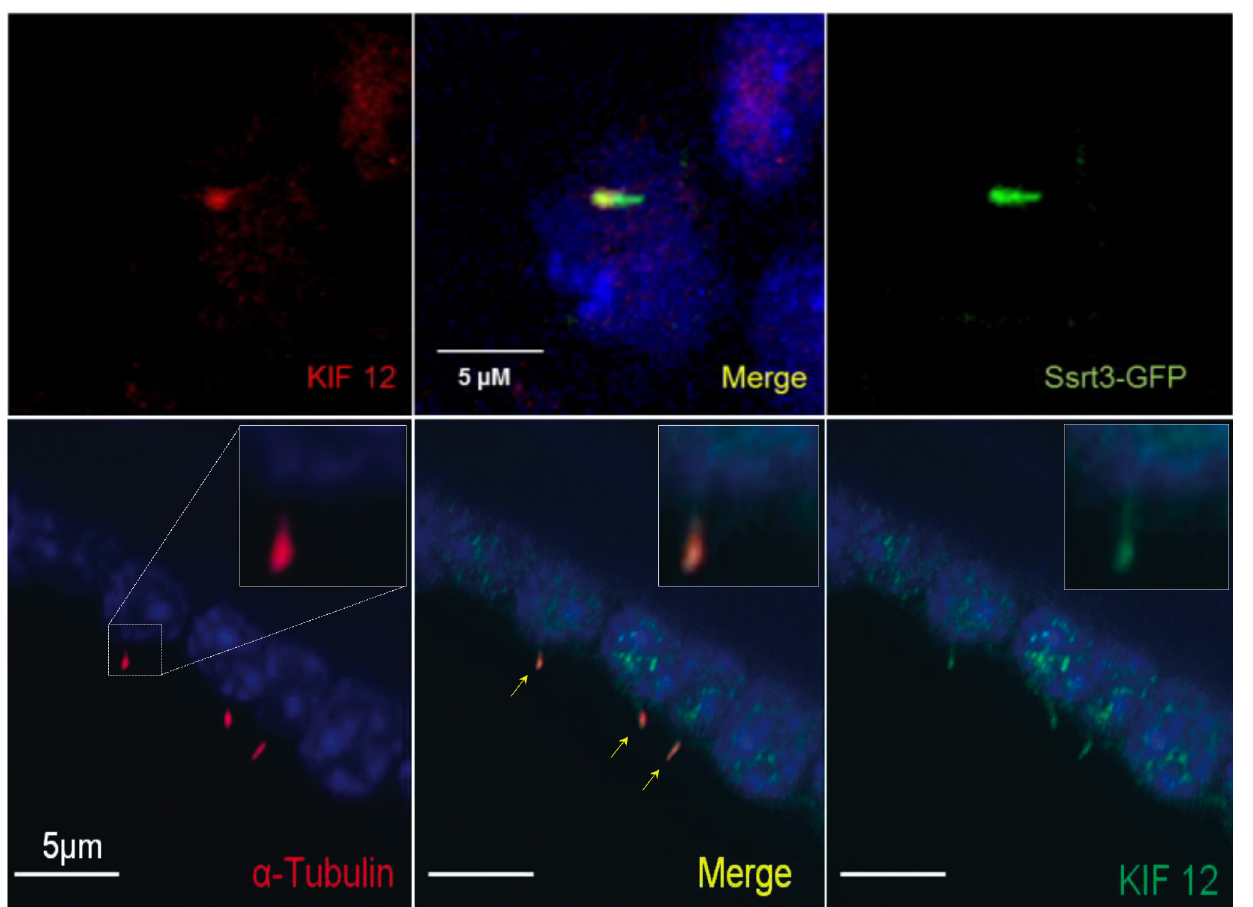
Fig 5. Kinesin 12 localizes to primary apical cilium. Upper panel shows representative immunofluorescent micrographs of kinesin 12 ( Kif12 ; red) co- localized with a GFP-tagged primary cilia marker, somatostatin receptor 3 ( Sstr3 -GFP; green) in a mIMCD cell line expressing Sstr3 -GFP. Lower panel demonstrates co-localization of kinesin 12 with α -tubulin, another commonly used primary cilia marker. The right upper corner insert represents magnification of the left uppermost primary apical cilium (highlighted in the lower left panel ). Together, these data implicate kinesin 12 as a primary cilia-associated